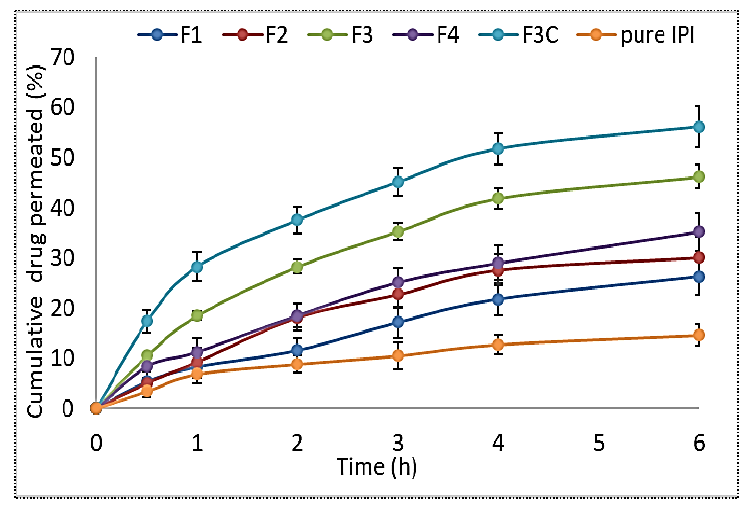
Figure 4. Cumulative drug permeation of IPI vesicles (F1, F2, F3, F4), IPI chitosan vesicle (F3C), and pure IPI. Study performed in triplicate and data shown as mean ± SD.